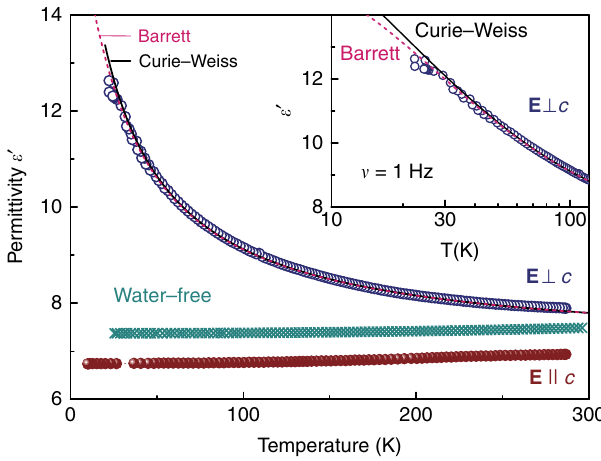
Figure 2 | Dielectric permittivity of a beryl crystal. Temperature dependence of the dielectric permittivity of a hydrated beryl crystal at low frequencies ( n ¼ 1Hz) for E > c (blue symbols) and E ||c (brown symbols). For comparison, the data for a dehydrated crystal in the polarization E > c (green symbols) are also plotted. The inset enlarges the low-temperature range in a logarithmic temperature scale. The solid and dashed lines correspond to fits by Curie–Weiss (equation (1)) and Barrett equations (equation (11)), respectively. The Curie–Weiss parameters are T C ¼ (cid:2) 20K, C ¼ 255K, and the Barrett fit parameters are T C ¼ (cid:2) 20K, T 1 ¼ 20K, C ¼ 255K; the temperature-independent contribution to the permittivity from higher-frequency excitations is e N ¼ 7.